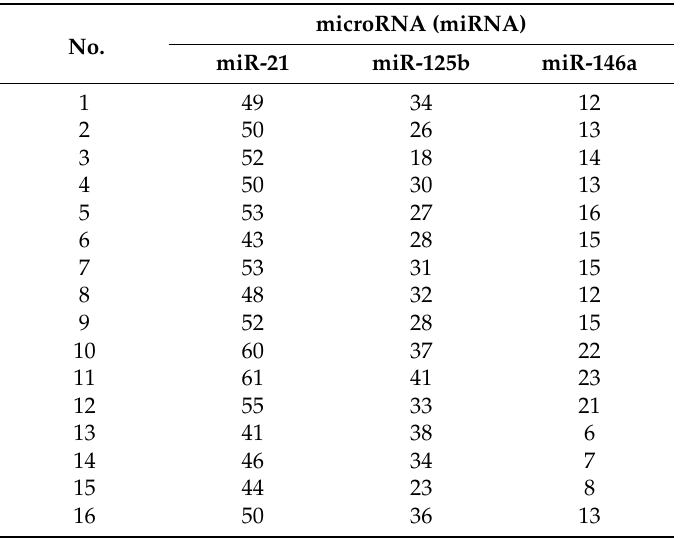
Table 3. Inhibitory effects (%) of the polyphenol fraction of blueberries against miR-21, miR-125b, and miR-146a. microRNA (miRNA) No. miR-21 miR-125b miR-146a